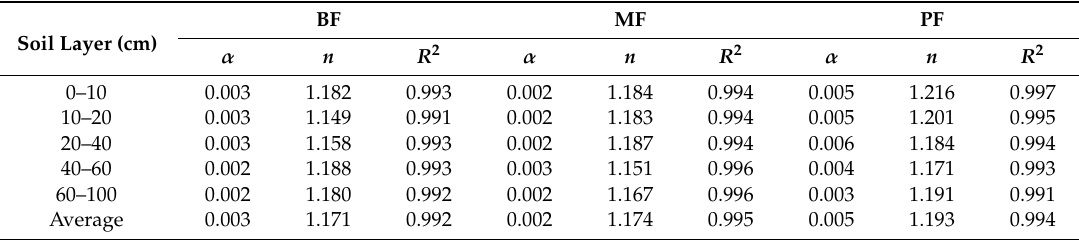
Table 2. Parameters describing the soil water retention curve for the three forests across soil depth. Soil Layer (cm)